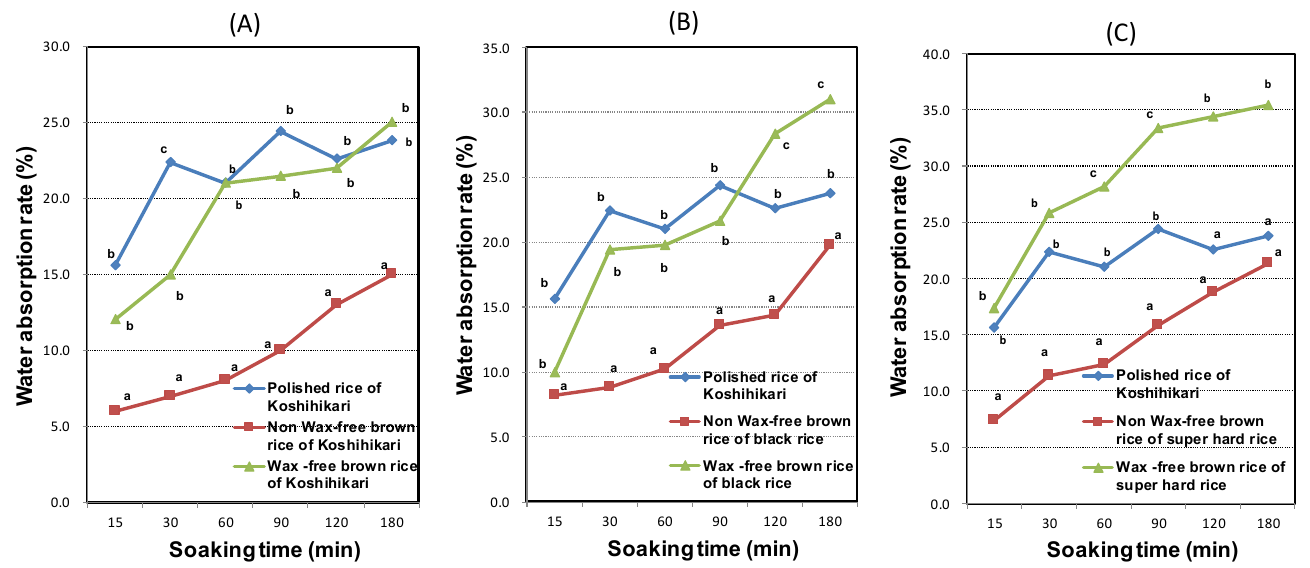
Figure 1. Water absorption rates of three kinds of wax-free brown rice and brown rice. Among the water absorption rates after in same soaking time, different letters (a, b, etc.) denote a statistically significant difference. Water absorption of polished Koshihikari rice is shown as a control (blue line) ( A ); water absorption rates of brown Koshihikari rice and wax-free brown Koshihikari rice ( B ); water absorption rates of brown Okunomurasaki (black) rice and wax-free brown Okunomurasaki rice ( C ); water absorption rates of brown Niigata 129 go (super hard) rice and wax-free brown Niigata 129 go rice.